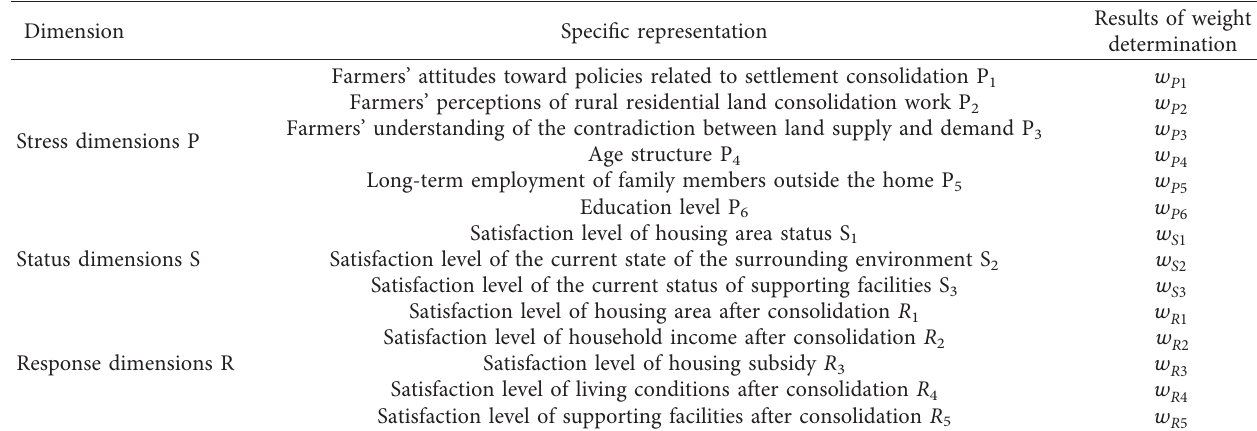
Table 3: Representation of the weight of each factor in the structure of farmers’ willingness in the estimation of rural residential land consolidation